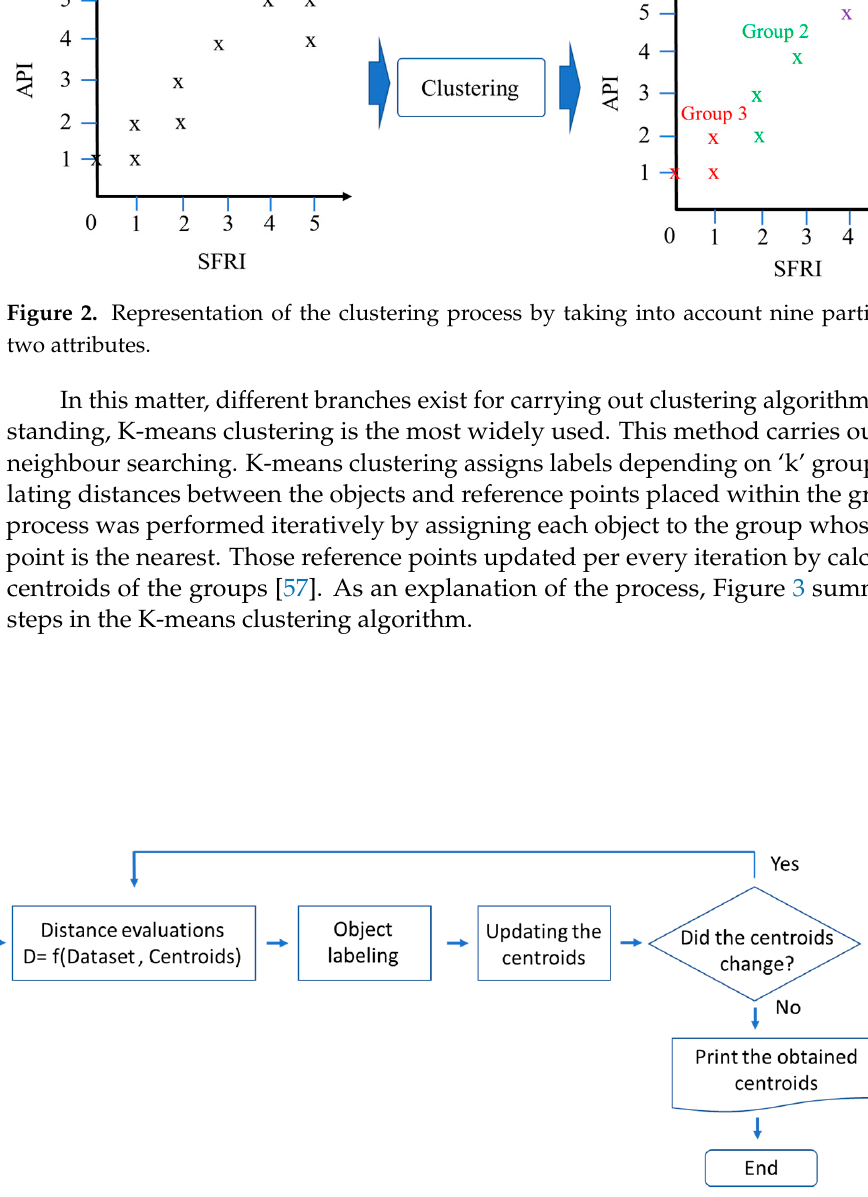
Figure 3. Block diagram for the steps in the K-means clustering algorithm.